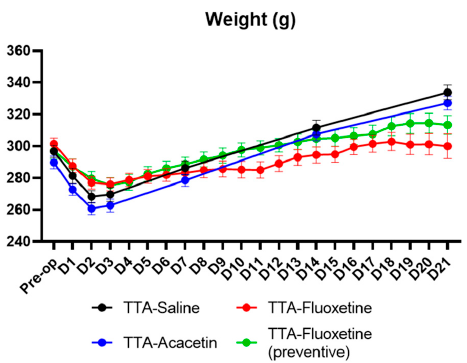
Figure 5. Illustration of the weight monitoring of each group at several time points after UVL.